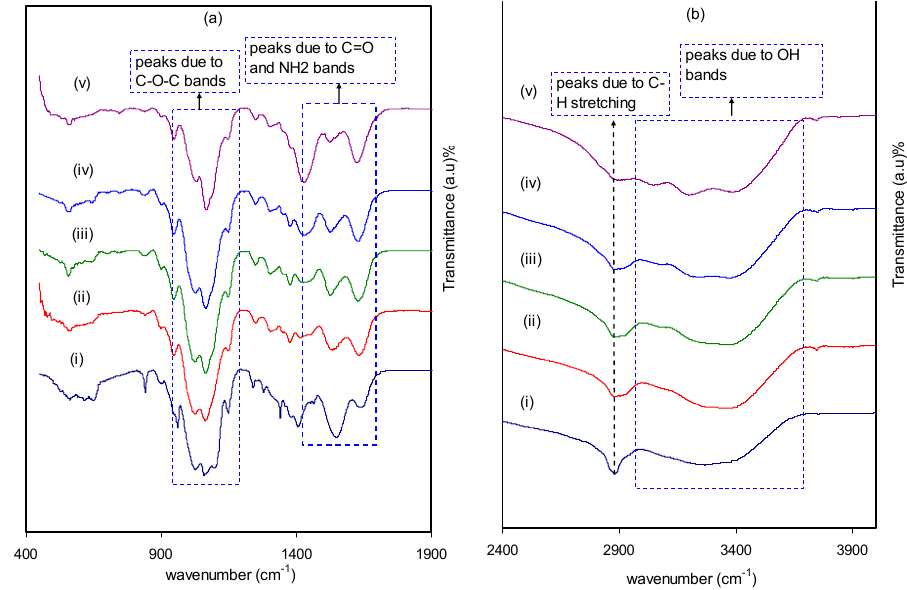
Figure 1. Spectrum of (i) CSPX0 (pure CS:PEO), (ii) CSPX1, (iii) CSPX2, (iv) CSPX3, and (v) CSPX4 in the range ( a ) 400 cm –1 to 1900 cm –1 , and ( b ) 2400 cm –1 to 3900 cm –1 .